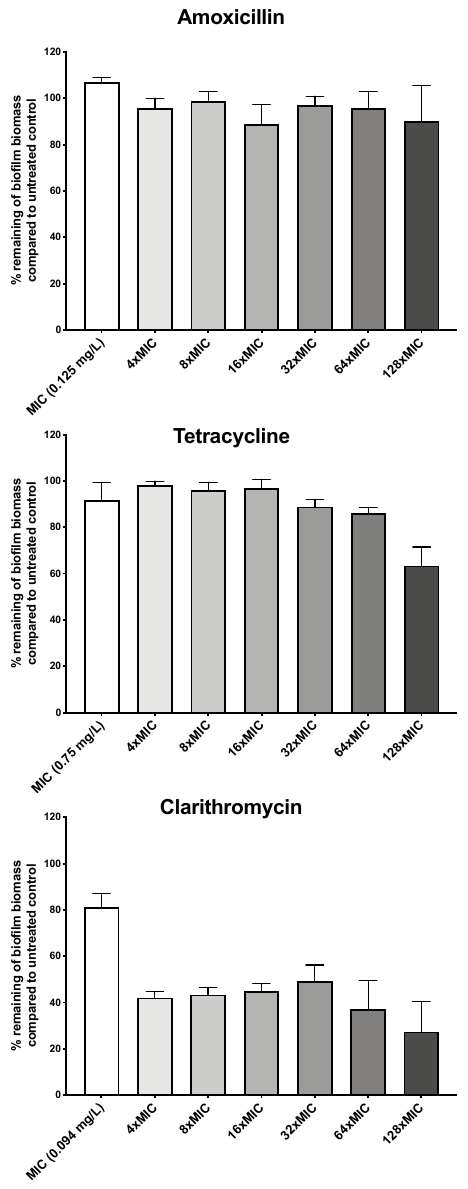
Figure 1. H. pylori biofilm growth is associated with high level tolerance towards amoxicillin, tetracycline, and clarithromycin. The percentage of remaining H. pylori G27 biofilm biomass after exposure to different concentration of amoxicillin, tetracycline, or clarithromycin compared to untreated control. Biofilms were grown for 48 h and then, exposed to antibiotics at the indicated concentrations for 24 h. Control/untreated biofilms were exposed to fresh media without antibiotic for the same time period. Biofilm were quantified using crystal violet. The percent biomass remaining was determined relative to the untreated control. Experiments were performed three independent times with at least 8 technical replicates for each. Error bars represent standard errors of the mean.